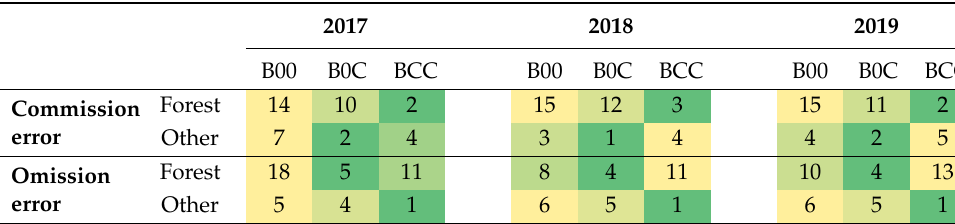
Table 5. Temperate site errors (%) based on GEDI forest presence/absence validation dataset. B00—classification using backscatter annual statistics, B0C—adding long-term coherence, and BCC—further adding short-term coherence statistics. Complete matrices in Appendix A (Table A2). Cells are shaded with a green-yellow gradient, indicating lower and higher errors.